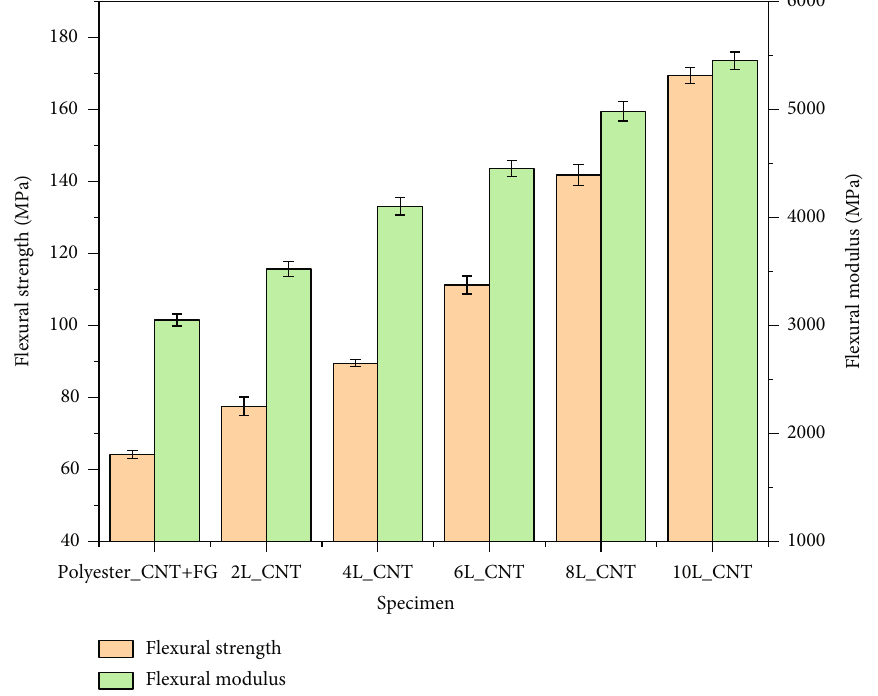
Figure 15: MWCNT reinforced with sandwich-structured composite ’ s fl exural strength and fl exural